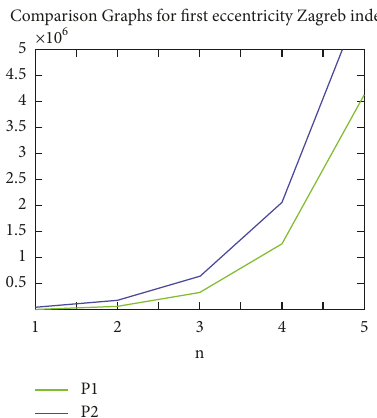
Figure 4: Graphical comparison between ECI of P